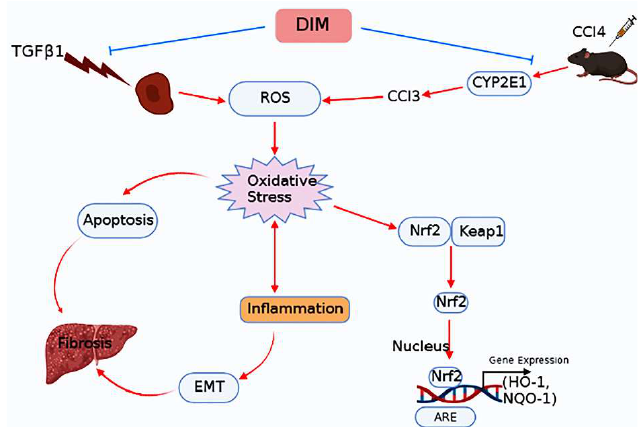
Figure 10. A schematic diagram showing molecular mechanisms involved in the protective effect of DIM against chronic liver injury by modulating ROS, oxidative stress, EMT, and fibrosis. In the figure, DIM inhibits TGF-β1-induced EMT by inhibiting intracellular ROS, oxidative stress, and apoptosis of heptocytes to prevent fibrosis, whereas DIM protects mice against CCl 4 -induced chronic liver injury by inhibiting ROS-mediated oxidative stress and Nrf2 cascade activation, thus reducing inflammation, EMT, and fibrosis.